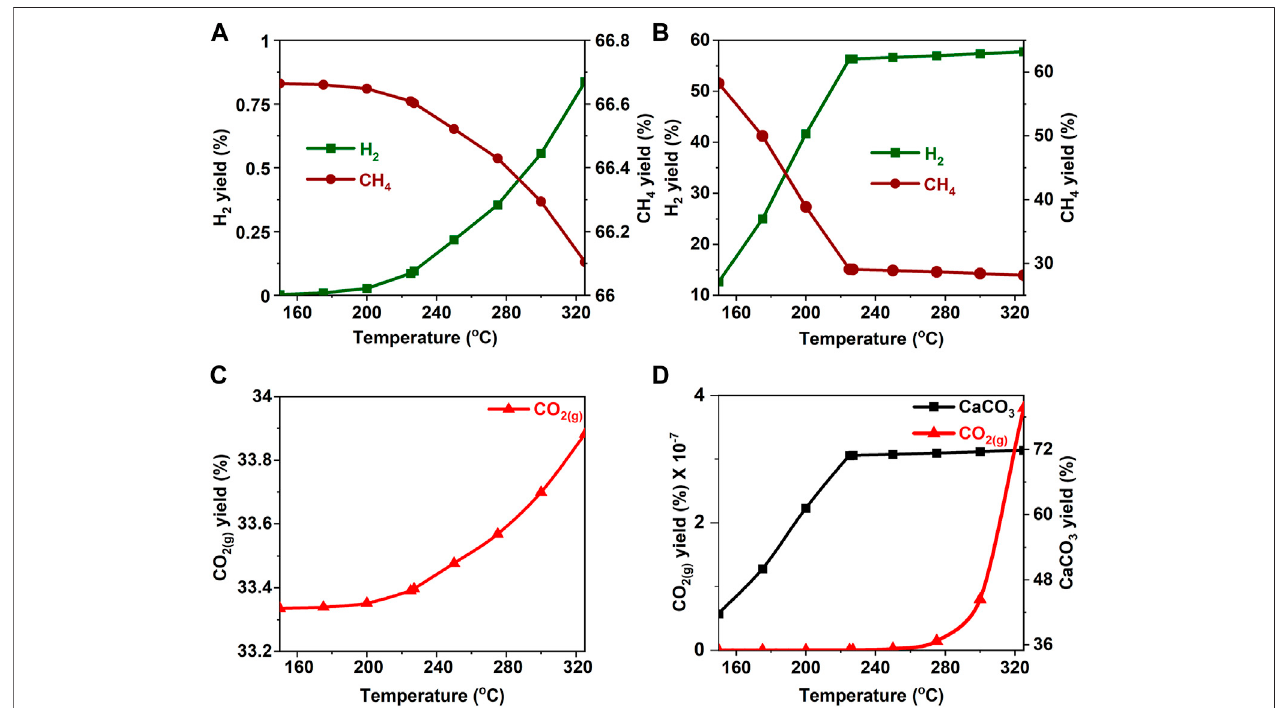
FIGURE13| Effect oftemperature ontheproduct yieldfromacetone (A , C) intheabsenceand (B) inthepresenceofcalcium oxide.TheyieldofCO 2 postcapture to produce calcium carbonate is represented in 11 (D) . These calculations are performed with temperatures of 227 ° C and pressures of 50 bar.